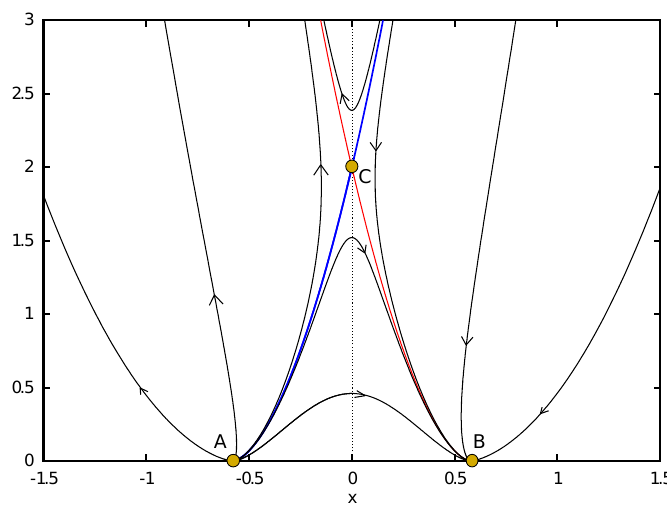
Fig. 1. The phase portrait of system (18)-(19). There three critical points: point A represents the unstable de Sitter universe, point B represents the stable de Sitter universe, and point C represents the Einstein-de Sitter universe. The red and blue trajectories lie on unstable and stable invariant manifolds, respectively. It is assumed ƒ is positive (for illustration ƒ D 1